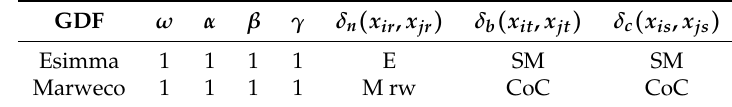
Table 2. Two examples of the mixed variable distances derived from the generalized distance function